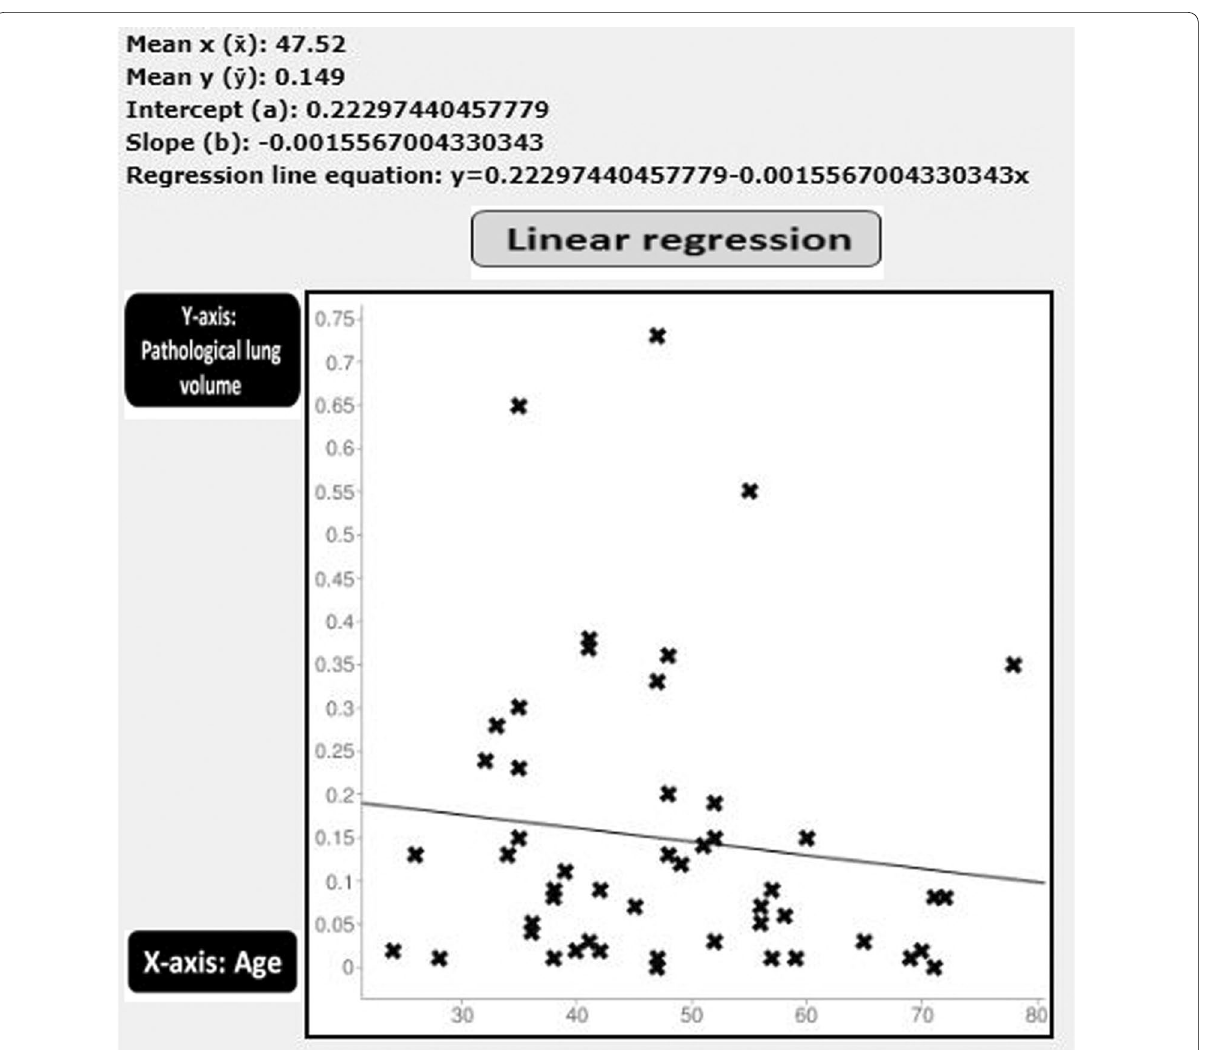
Fig. 8 Schematic presentation of Pearson correlation coefficient and linear regression analysis between the patients’ age ( X -axis) and the number of pathological lung changes ( Y -axis): No statistical relationship was shown ( r